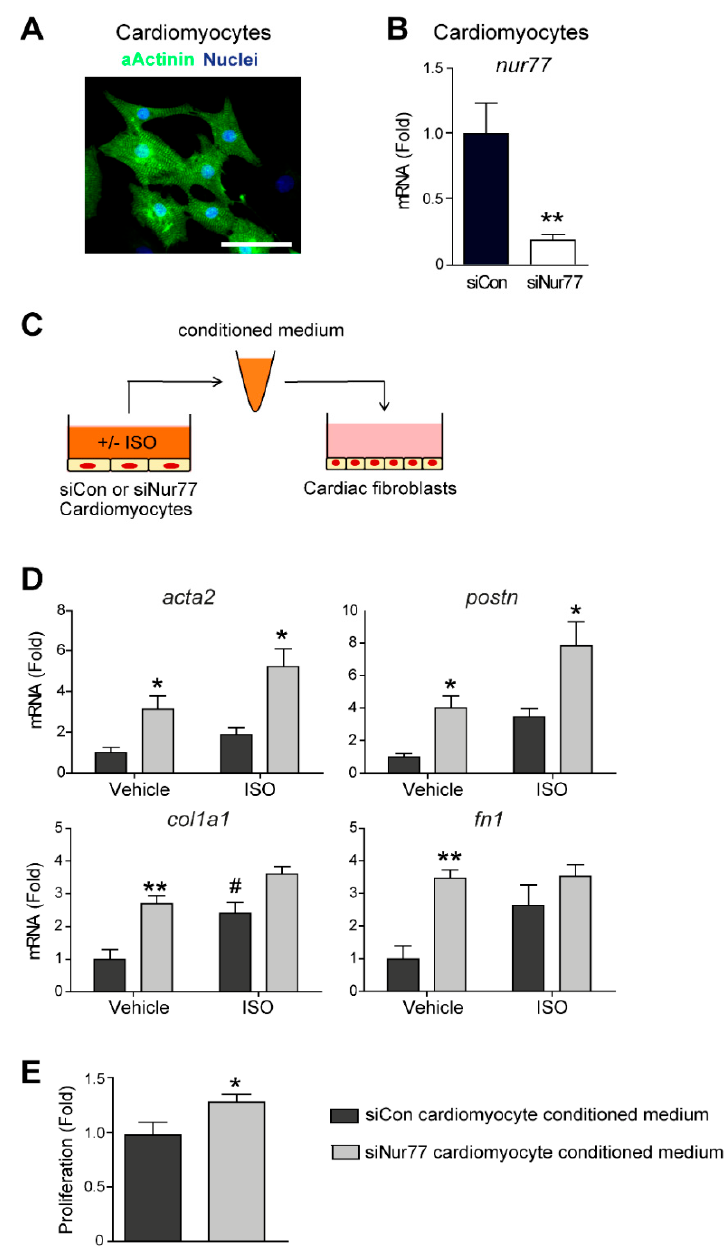
Figure 4. Paracrine factors from Nur77-silenced cardiomyocytes promote a MyoFB phenotype in CF. ( A ) Primary neonatal rat ventricular cardiomyocytes in culture were identified by expression of α -actinin. Scale bar represents 100 µ m). ( B ) Nur77 mRNA expression after siRNA-mediated knockdown of Nur77 in neonatal rat ventricular cardiomyocytes, as measured by qPCR. ( C ) Schematic presentation of the experimental setup. ( D ) mRNA expression of MyoFB markers in CF after incubation with siCon or siNur77 cardiomyocyte conditioned medium, as assessed by qPCR. ( E ) Proliferation of CF after incubation with siCon or siNur77 cardiomyocyte conditioned medium, as measured by BrdU incorporation. ( D , E ) Conditioned medium stimulation (1:2 ratio with fresh medium) was for 24 h. n = 3–4 independent experiments. Data presented as mean + SEM; # p < 0.05 vs. siCon vehicle; * p < 0.05, ** p < 0.01 vs. siCon same stimulus.